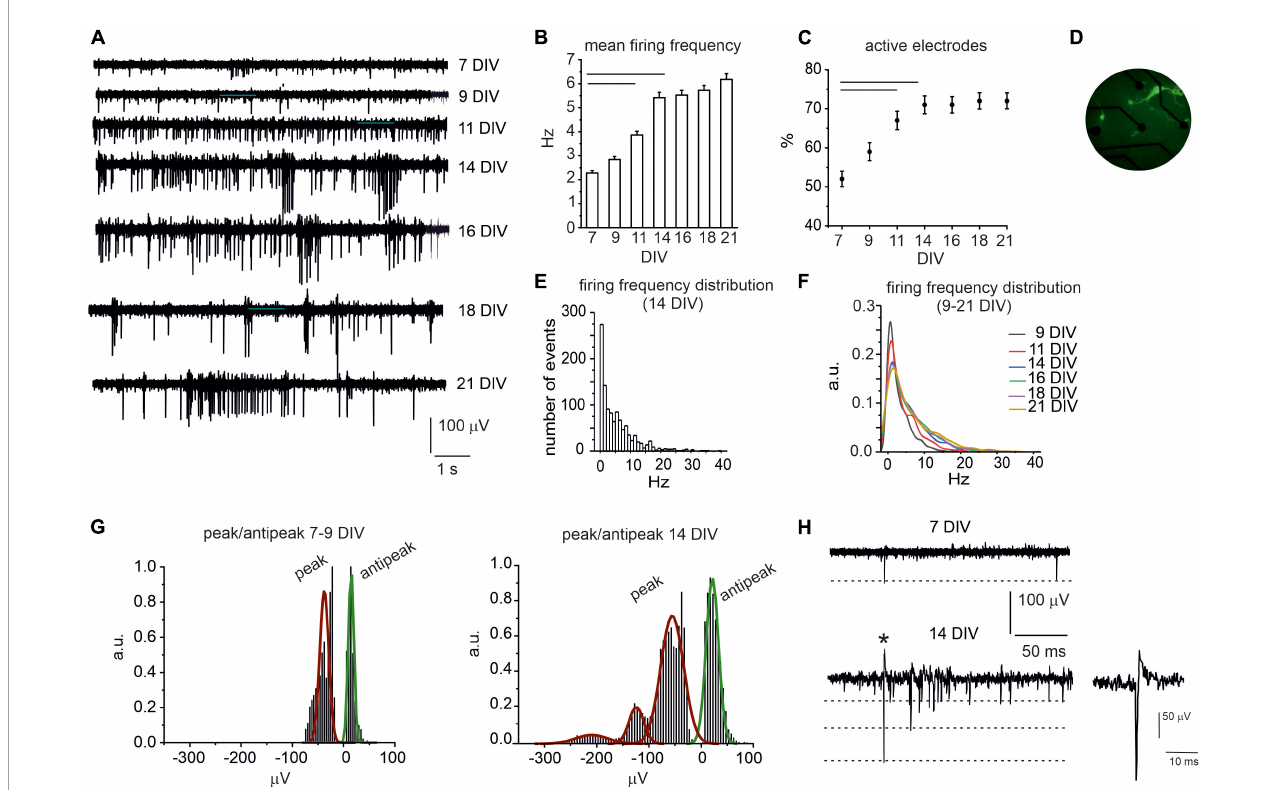
FIGURE1 Spontaneous AP firing activity of midbrain neurons during network development. (A) Representative traces measured by the same electrode at different DIV (7–21). (B) Bar histogram of mean firing rate at different DIV. Statistical difference is indicated by the horizontal lines (7 DIV vs. 11 DIV, p < 0.0001; 7 DIV vs. 14 DIV, p < 0.0001). (C) Percentage increase of active electrodes versus time (7 DIV vs. 11 and 14 DIV p < 0.0001). (D) Photograph of midbrain TH-GFP neurons (14 DIV) cultured on microelectrode arrays (MEA). (E) Distribution of the spontaneous firing rate at 14 DIV. (F) Distribution of the spontaneous firing rate in the range 9–21 DIV (a.u. arbitrary units). (G) Distribution of negative peak and antipeak mean values for young (left) and elder neurons (right). (H) Representative AP traces at 7 DIV and 14 DIV; the dashed lines indicate the amplitude of the negative AP peaks. The single AP